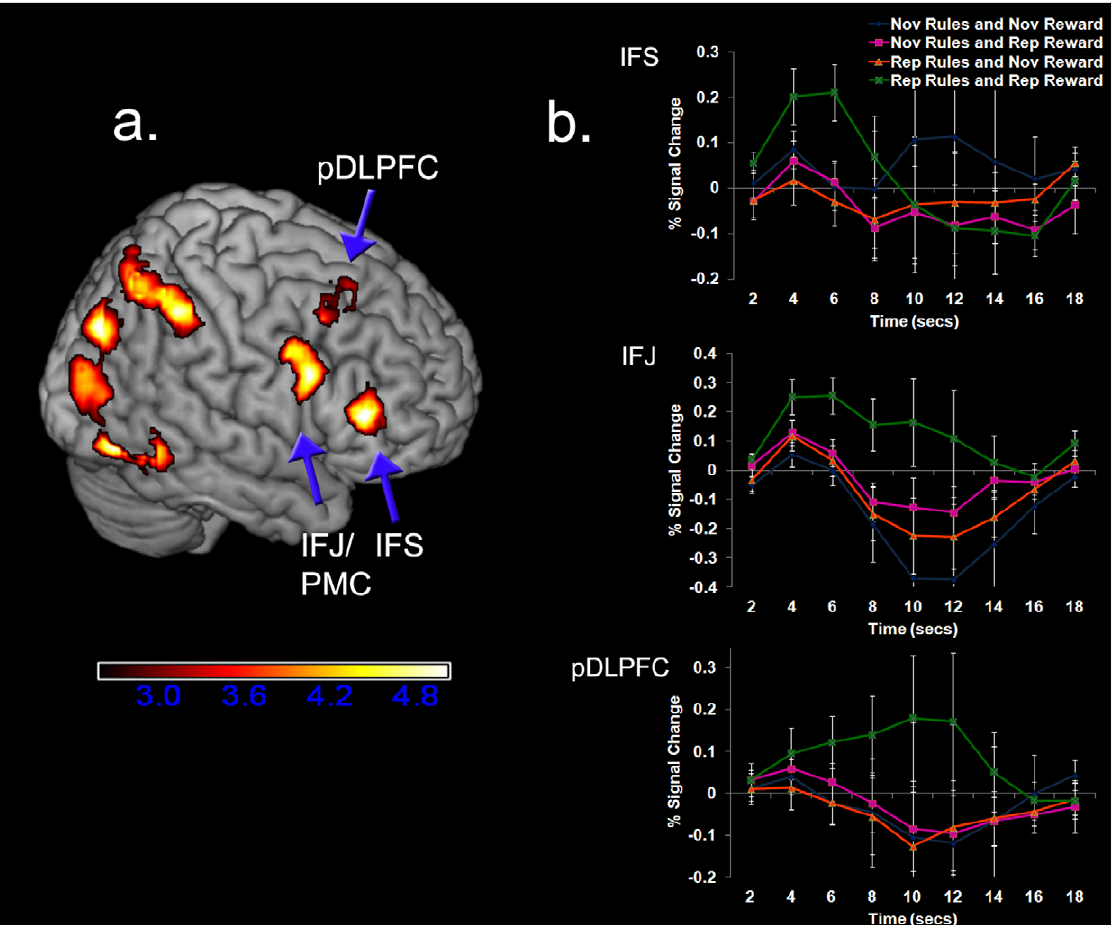
Figure 3. Regions Showing Repetition Enhancement for Repetition of a Specific Rule-Outcome Pairing ( Z . 2.57, p , .05 FWE cluster corrected for the whole-brain). A. Right lateral view showing regions of the LPFC exhibiting this effect. B . Activation time-course for the IFS, IFJ, and posterior DLPFC time-locked to the onset of the second instruction. The color scale denotes t-values. Nov=novel, rep=repeated. Error bars represent one (within-subject) standard error of the mean based on Loftus and Masson [69]. doi:10.1371/journal.pone.0051637.g003 Table 1. Regions exhibiting fMRI-adaptation for repetition of rules and reward.